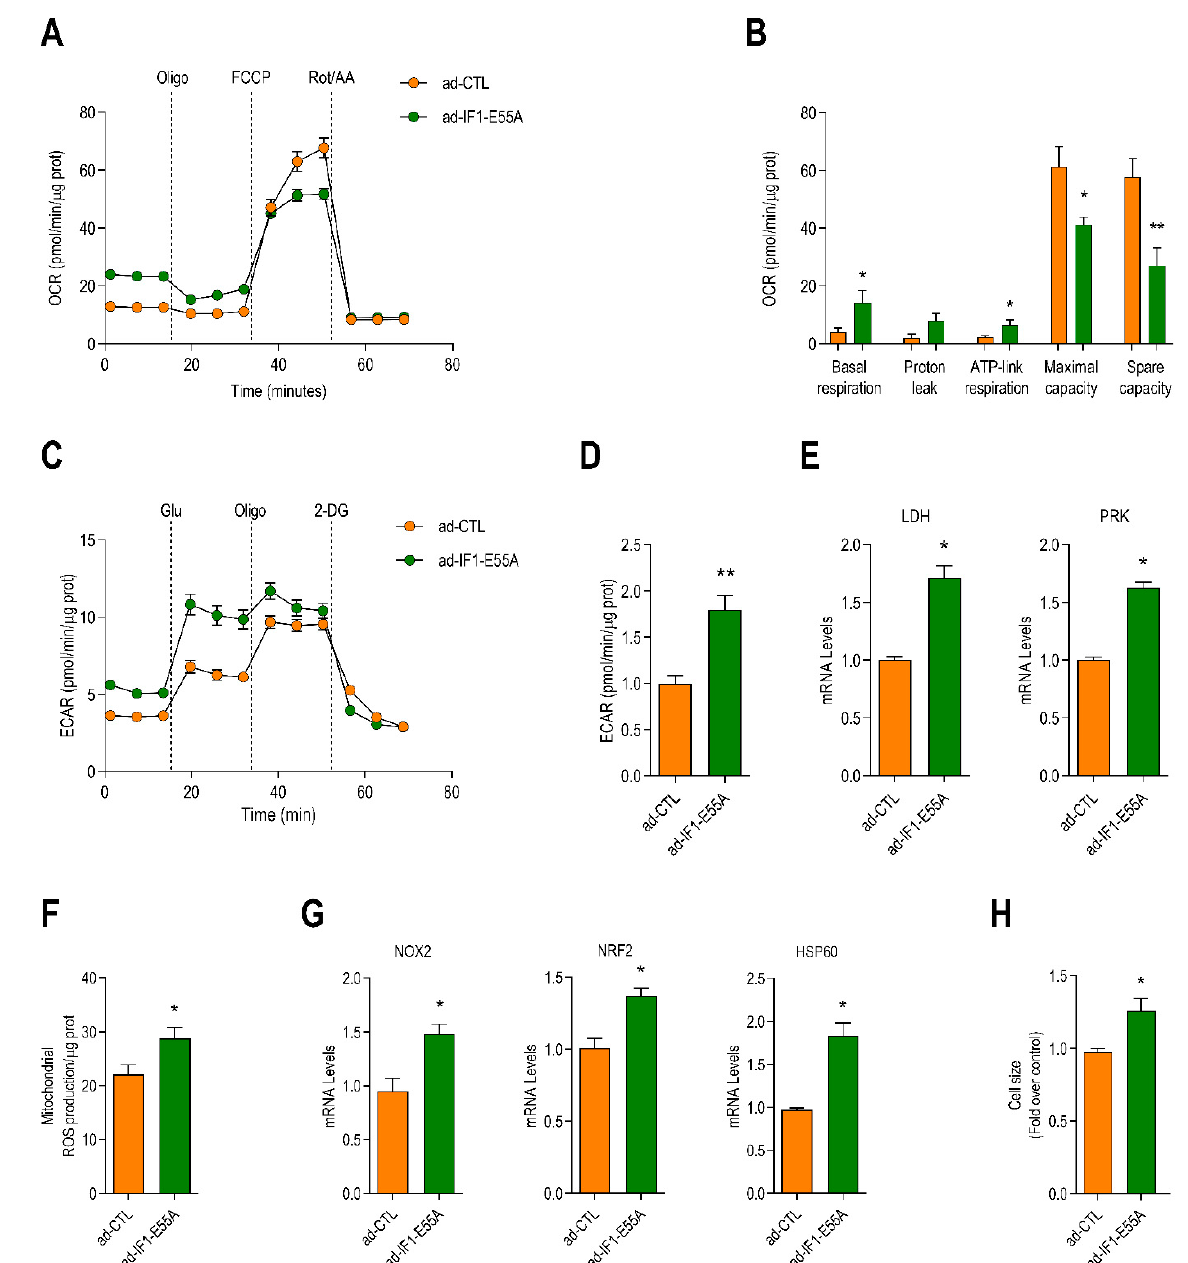
Figure 3. An IF1 mutant incapable of binding to ATP synthase induces similar degrees of mitochondrial stress and cardiomyocyte hypertrophy. NRVMs were infected with an adenovirus expressing an IF1 mutant harboring an E55A substitution that renders the protein unable to interact with ATP synthase or control virus (ad-CTL) for 48 h. ( A ) Changes in the oxygen consumption rate (OCR) of NRVMs after serial treatments with oligomycin (oligo), FCCP, and rot + AA assessed with the Seahorse system ( n = 5). ( B ) Bar graph depicting differences in basal respiration, ATP-linked respiration, maximal respiration, and mitochondrial spare capacity ( n = 5). ( C ) Changes in the extracellular acidification rate (ECAR) in cells infected with ad-IF1-E55A or ad-CTL after serial additions of glucose, oligomycin, and 2-deoxyglucose (2-DG, n = 4). ( D ) Bar graph depicting differences in glycolysis in NRVMs treated as in F ( n = 4). ( E ) mRNA levels of lactate dehydrogenase ( LDH ) and pyruvate kinase ( PRK ). ( F ) Basal mitochondrial ROS levels assayed with MitoSOX ® ( n = 4). ( G ) mRNA levels of NOX2 , NRF2 , and HSP60. ( H ) Bar graph depicting differences in cardiomyocyte cross-sectional area ( n = 5). Data are presented as mean ± SEM. * p < 0.05 and ** p < 0.01 vs. ad-CTL using the Mann–Whitney U -test or T -test where appropriate.